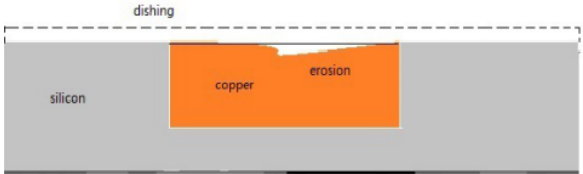
Figure 4: Dishing and